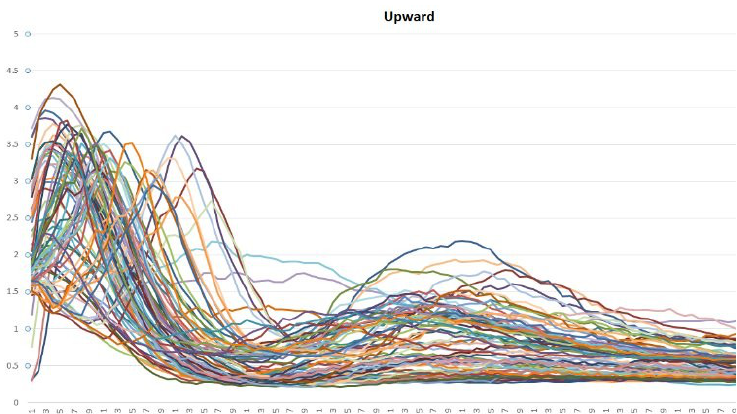
Figure 9. Samples that are related to the double upward movement. The Y -axis represents each sampling point of the vector that is related to each sample and the X -axis represents the signal amplitude (it was mapped between 0 and 5).